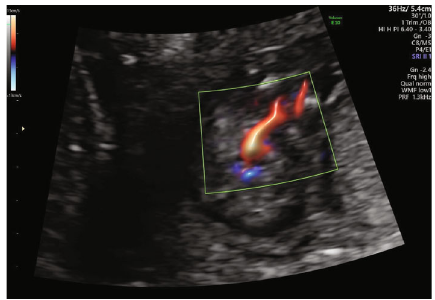
Figure 3: Color Doppler ultrasonography at the 13 weeks of gestation. A single umbilical artery was seen.